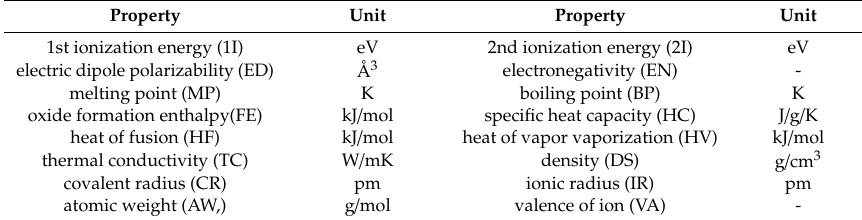
Table 1. Physicochemical property for featuring each element.